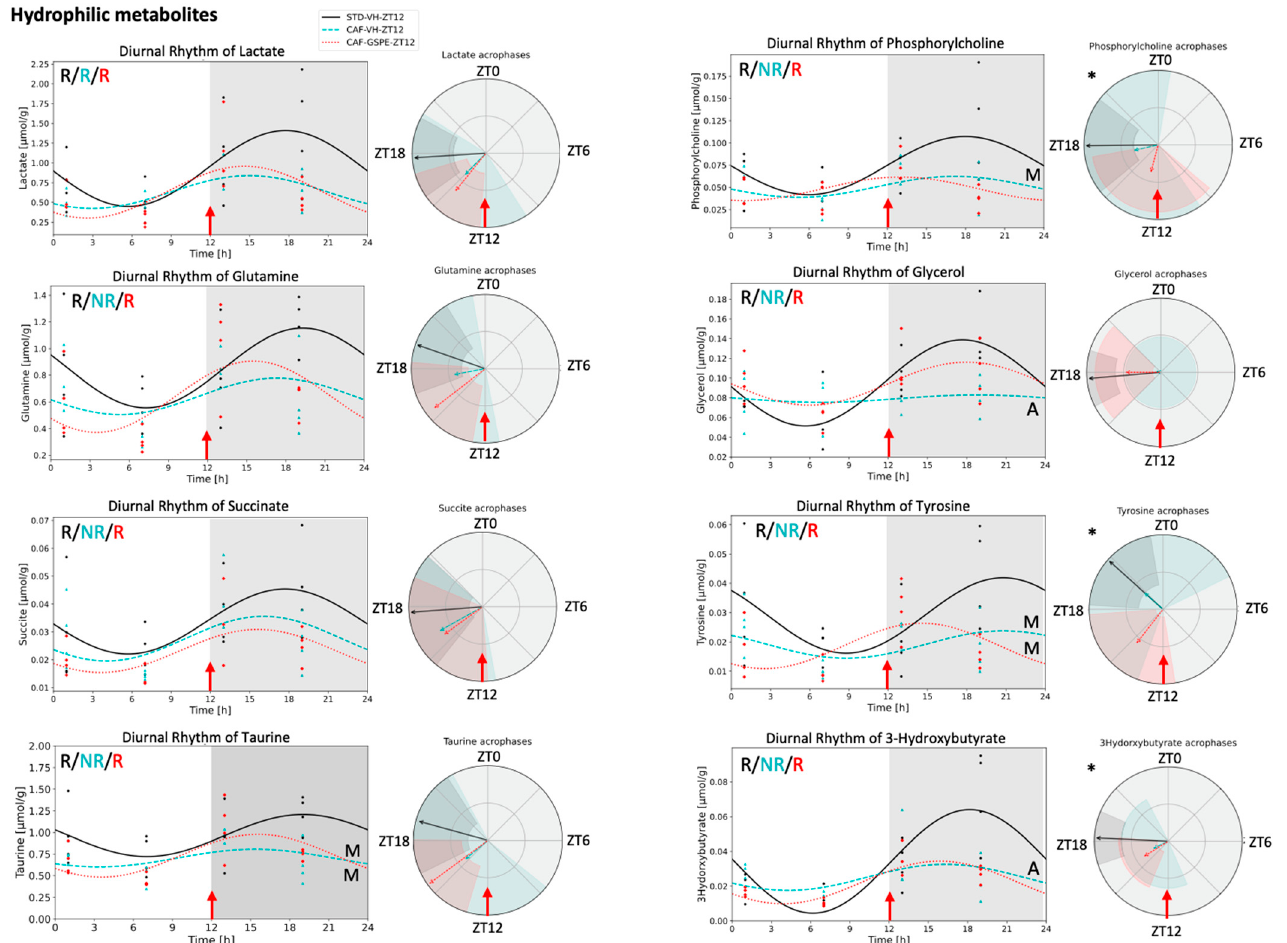
Figure 3. Hydrophilic metabolites which recovered their diurnal rhythm lost under cafeteria diet through GSPE administration in ZT12. Circadian parameters such as rhythmicity, mesor, amplitude, and acrophase were calculated using the CircaCompare algorithm based on Cosinor. Graphs showing diurnal rhythm and acrophase were performed using the Python package based on Cosinor. R, indicates significant rhythmicity; NR, indicates non-rhythmic; M, denotes significant mesor difference against STD-VH-ZT12; A, denotes significant amplitude difference against STD-VH-ZT12; * indicates significant acrophase difference between STD-VH-ZT vs CAF-GSPE-ZT12.